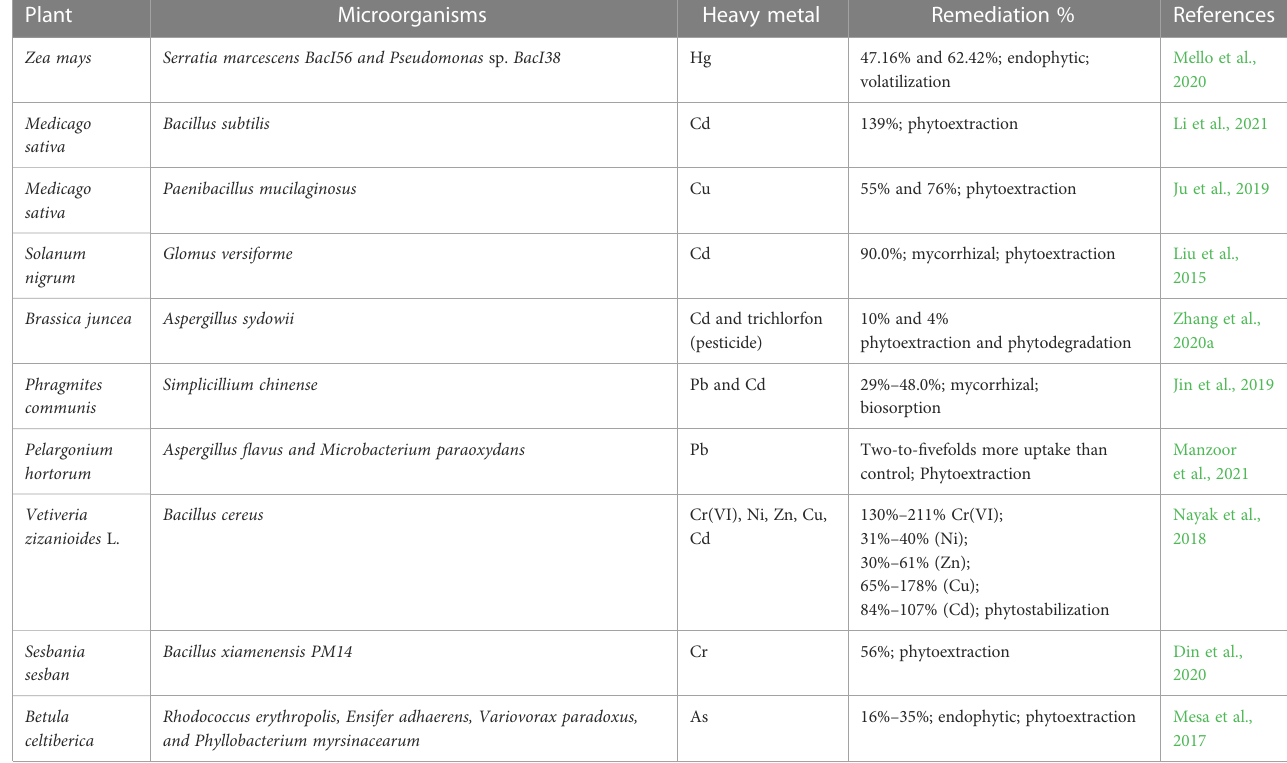
TABLE 3 Plant – microbe interaction in various mechanisms of heavy metal phytoremediation.